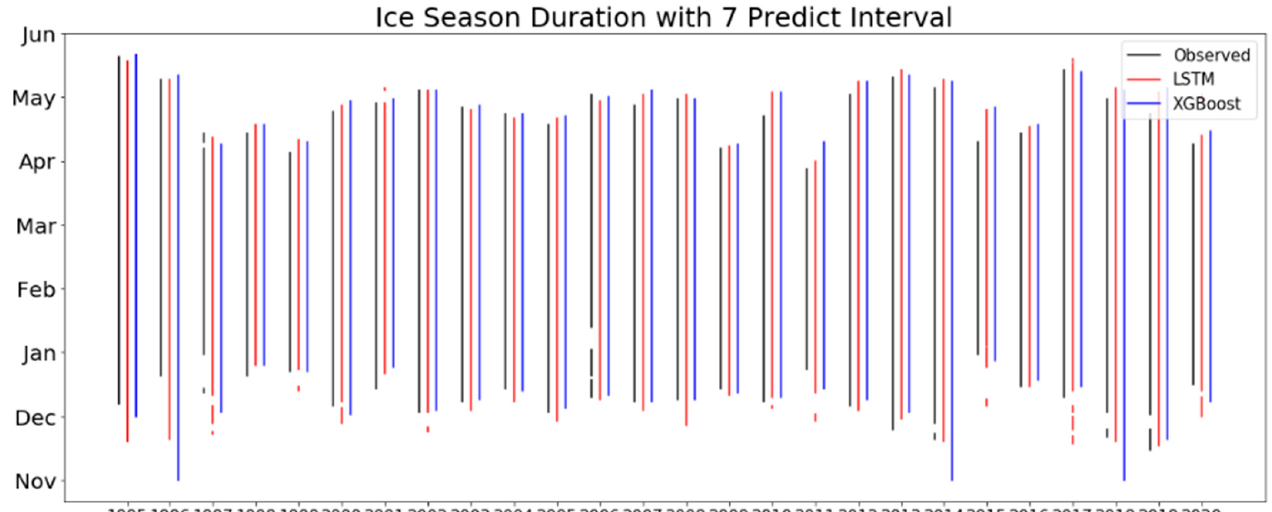
Figure 8. Ice duration for 7-day prediction from the winters of 1994/1995–2019/2020.